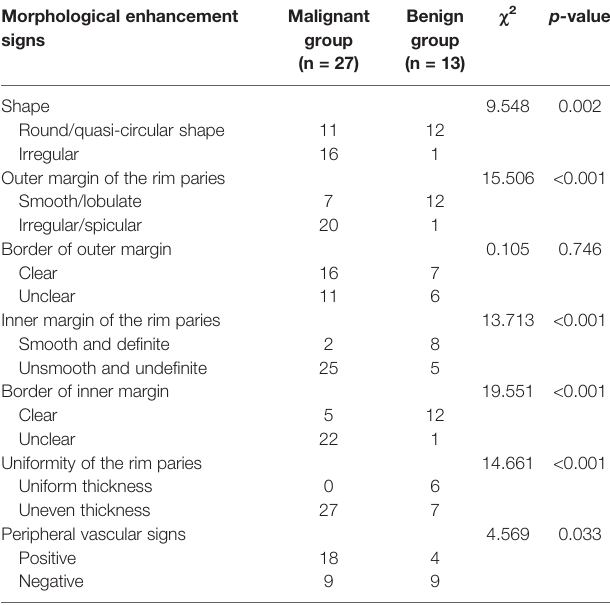
TABLE 2 | Morphological enhancement signs of the breast lesions with rim enhancements by CE-CBBCT. Morphological enhancement signs